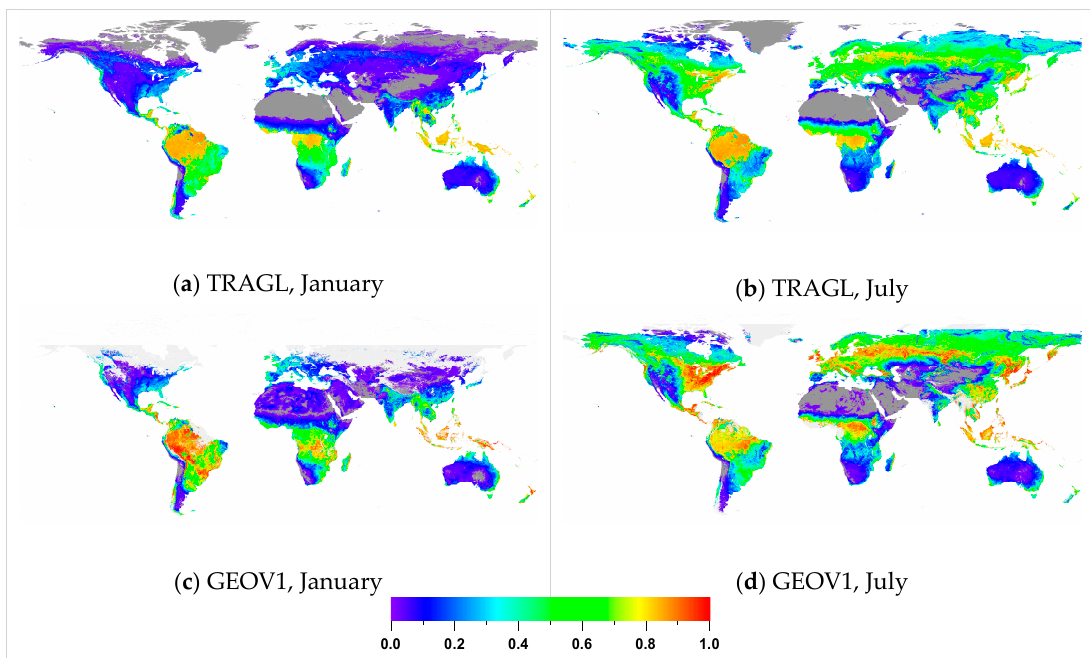
Figure 2. Global mean FCover for TRAGL ( a , b ) and GEOV1 ( c , d ) products from 2001 − 2005. Left panels : January. Right panels : July. Areas masked in dark gray correspond to pixels where the FCover values are zero and areas masked in light gray correspond to pixels where the FCover values are missing.